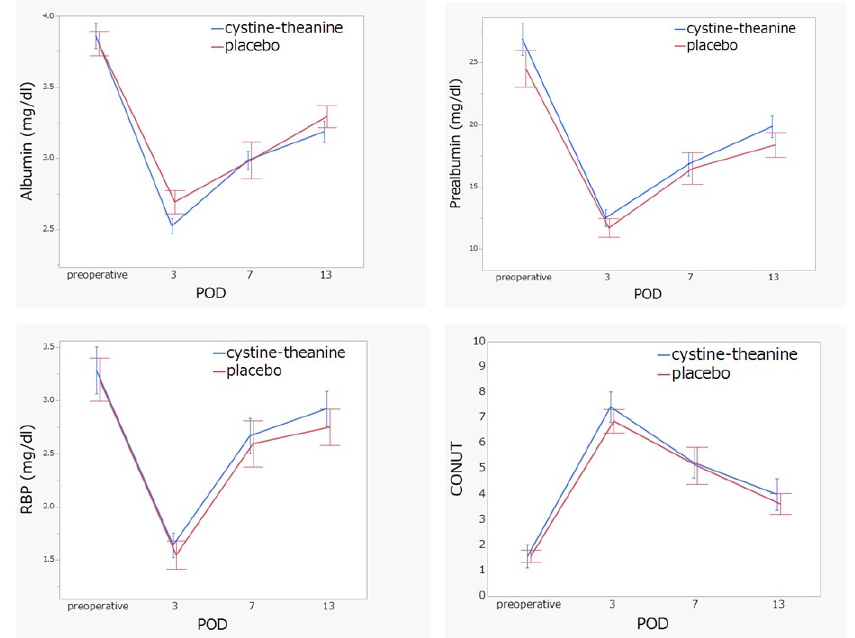
Figure 4. Albumin, prealbumin, retinol-binding protein (RBP), and CONUT score. There were no differences between the two groups in terms of the serum albumin, prealbumin, and RBP levels as well as the CONUT score.